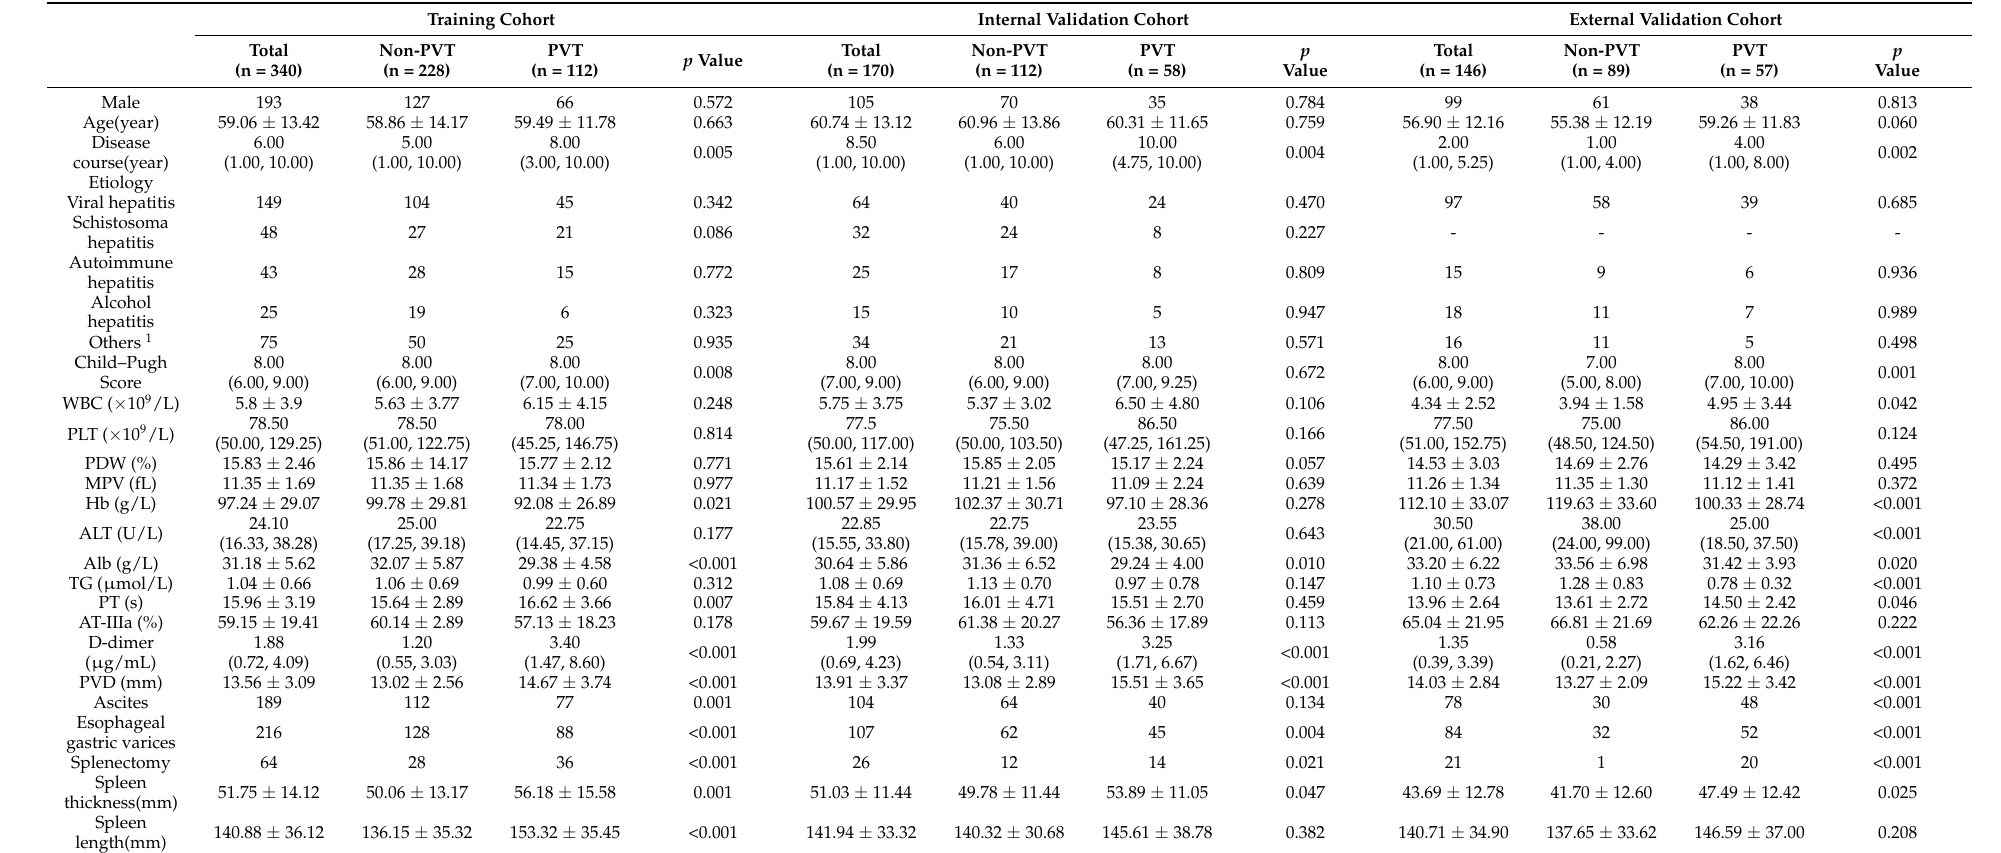
Table 1. Basic characteristic in training and validation